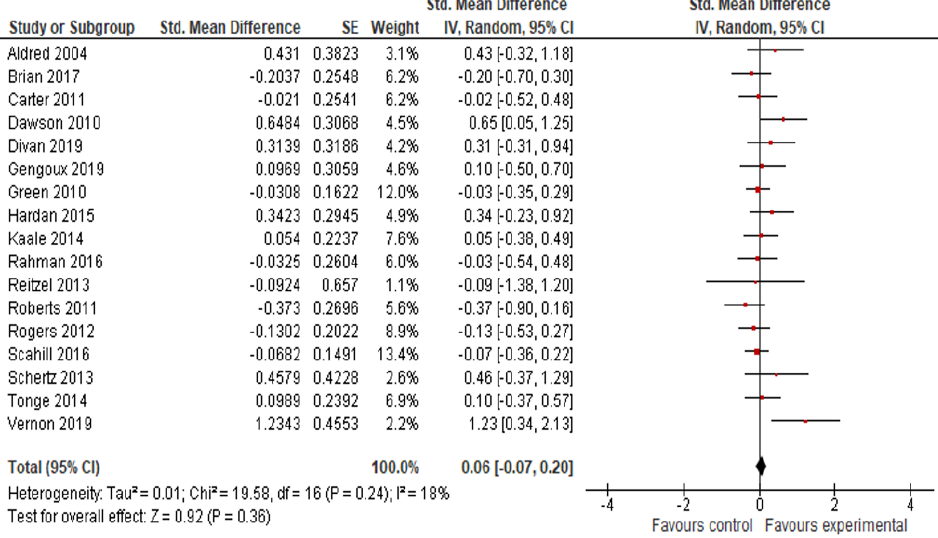
Figure 7. Forest plot for communication results. Overall effect [27–31,34,35,38,39,44,45,47,48,50,51,55,58].